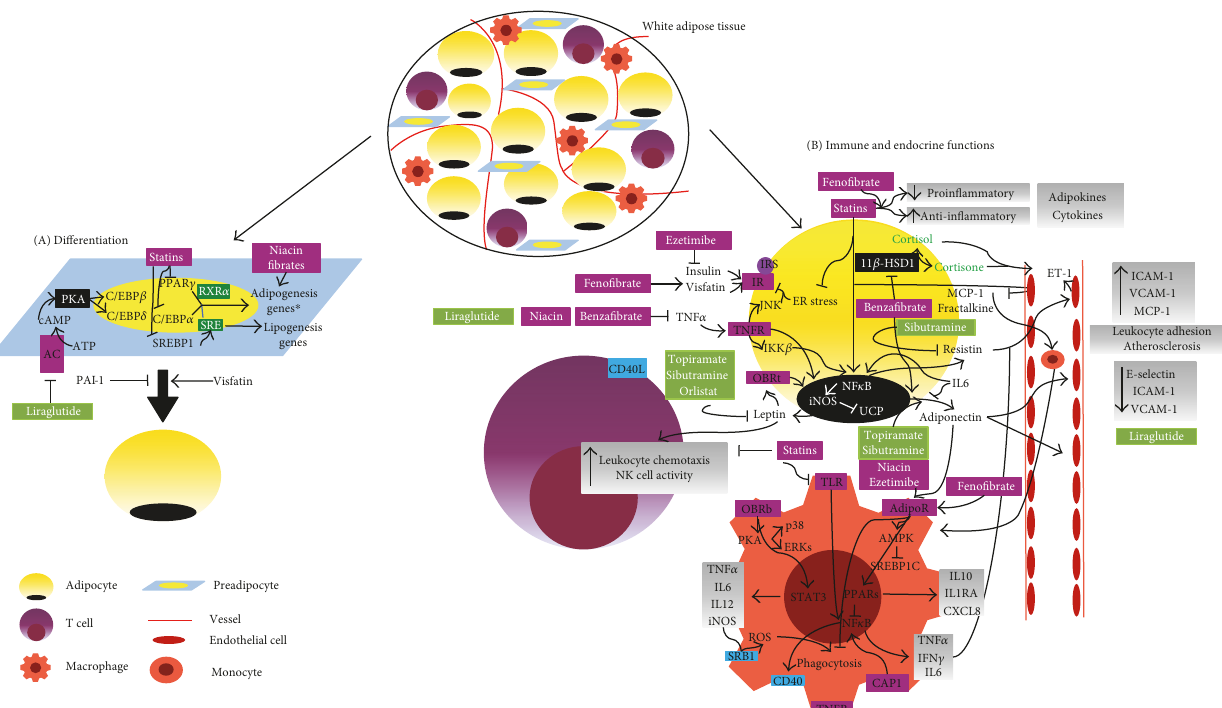
Figure 2: Schematic illustration of the main intracellular pathways underlying WAT metabolic functions and the e ff ects of drugs used in dyslipidemia and obesity on these pathways: B-oxidation ( ∗ through upregulation of ACS, CD36, MCD, and CPT1 genes and after stimulus as PPAR α agonist or adrenergic agonists, through upregulation of the AMPK pathway); lipolysis (sequentially by ATGL, HSL, and MGL actions); lipogenesis ( ∗ through upregulation of GLUT4; ACC genes). Statins induce adipocyte FA uptake, increasing LPL expression, while decreasing cholesterol release. ∗ Only in obese models, statins stimulate lipogenesis de novo; globally, fi brates inhibit lipogenesis and stimulate FA oxidation and thermogenesis ( ∗ through upregulation of PRDM16, PPAR- γ , and UCP-1 gene expression); niacin inhibits lipolysis and increases lipogenesis gene expression; orlistat enhances TG degradation. See text for